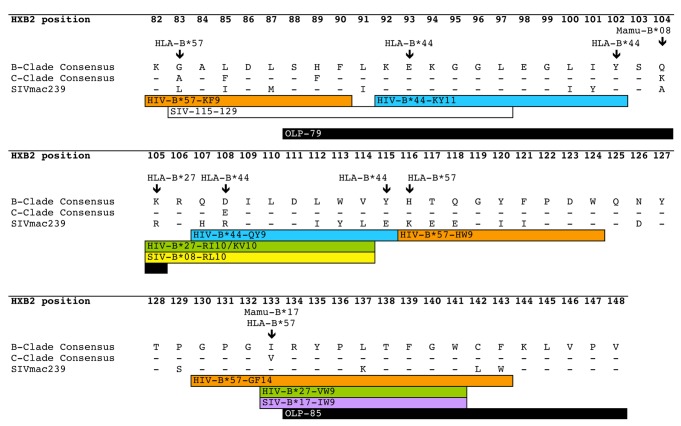
Map of central region of Nef showing sites of key epitopes and residues at which CD8+ selection pressure operates.Central conserved region of HIV-1 Nef is shown previously defined as HXB2 residues 81-160 [8]. Corresponding B-clade and C-clade consensus sequences are shown along with SIVmac239 consensus. Positions of epitopes restricted by alleles HLA-B*27 [37], HLA-B*57 [28,64,65] and HLA-B*44 are highlighted in green, orange and blue respectively. Regions homologous to Mamu-B*08 [36] and Mamu-B*17 epitopes [66] are also marked (yellow and purple respectively). SIV 115-129 also highlighted as a region recently associated with SIV control in macaques [41]. Responses to overlapping peptides 79 and 85 are associated with viraemic control, q<0.2 (black boxes). Sites of mutations selected by HLA-B*57, HLA-B*27, HLA-B*44, Mamu-B*08 and Mamu-B*17 are marked with arrows [29,36,67]. This highlights the substantial overlap between HIV and SIV epitopes restricted by alleles that are associated with favourable immune control.